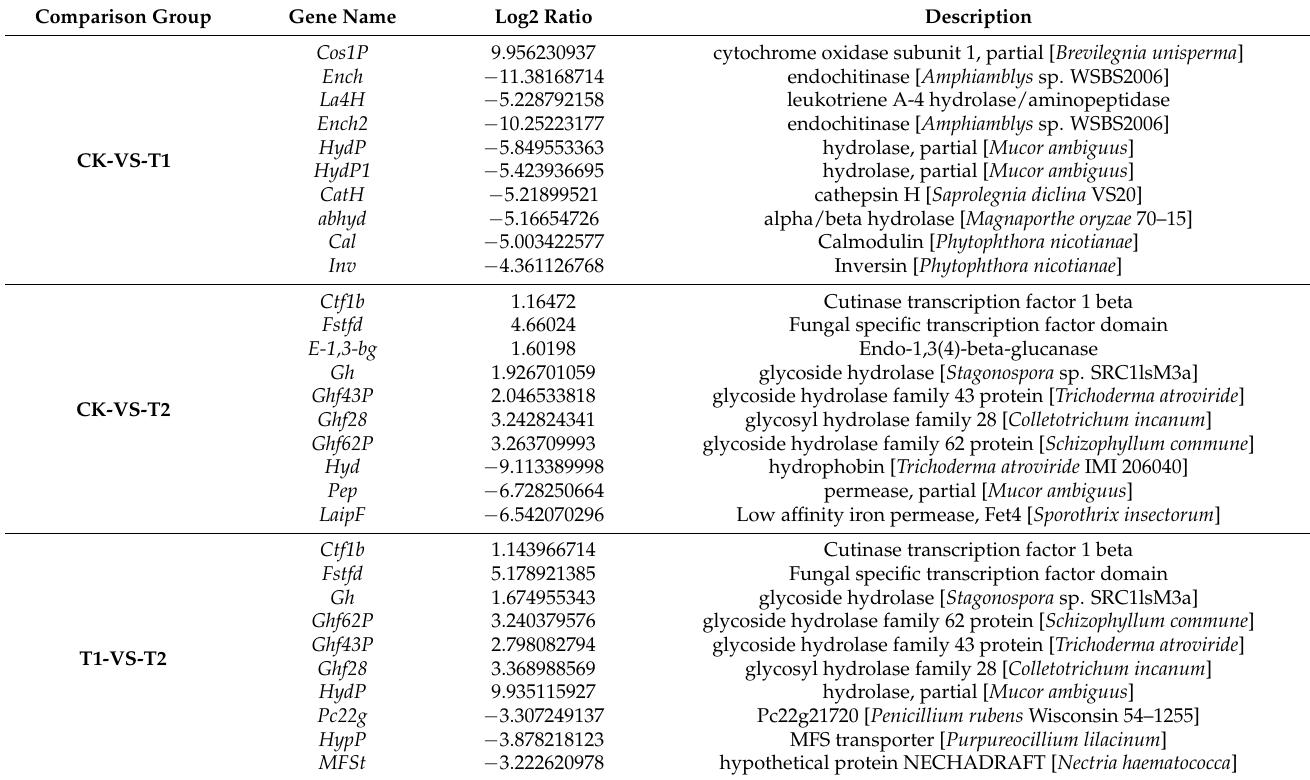
Table 1. Thirty Candidate validation genes.